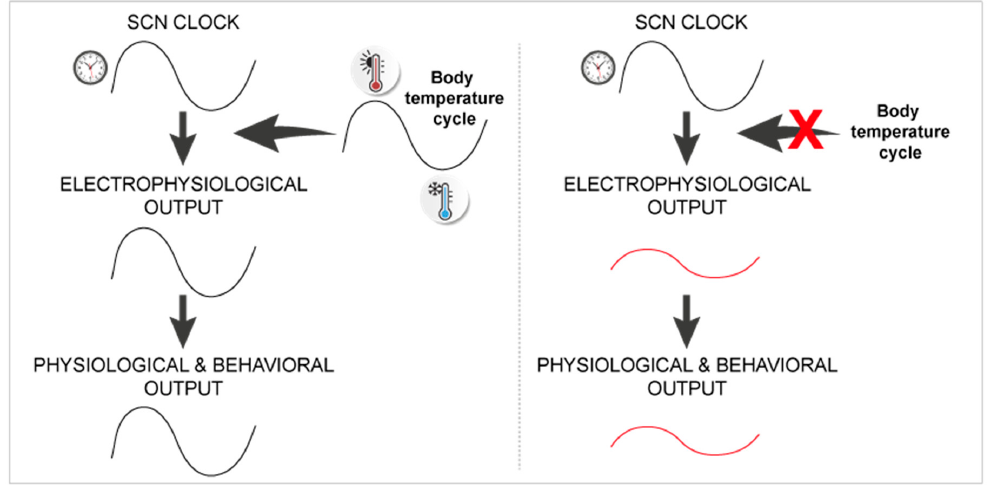
Figure 2. Temperature as a possible capacitor of circadian rhythms. Body temperature cycles may modulate SCN physiology downstream of circadian clock genes, and enable full-amplitude output rhythms in vivo (left panel) that may possibly be reduced in Hsf1 − / − mice with an altered heat shock response pathway, but a normal SCN molecular clockwork (right panel).